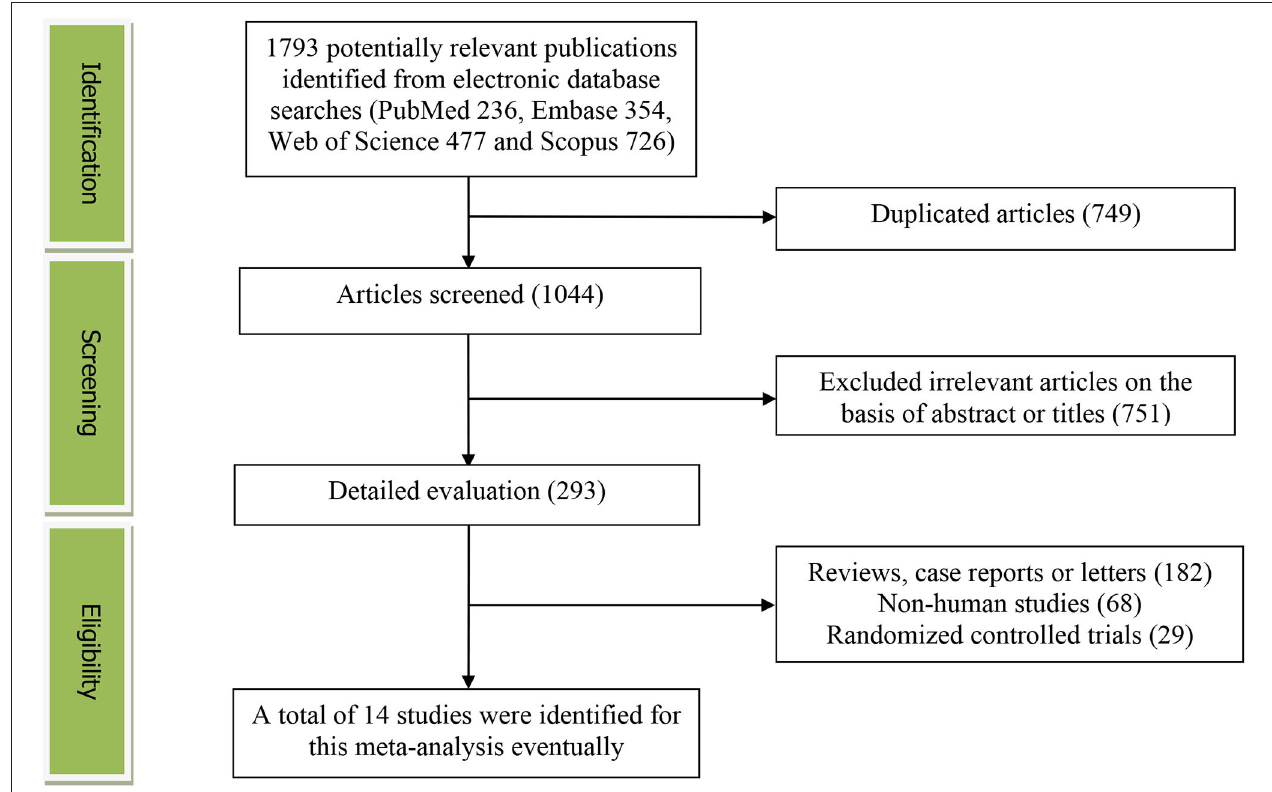
FIGURE 1 | The detailed flow diagram of the study identification and selection in this